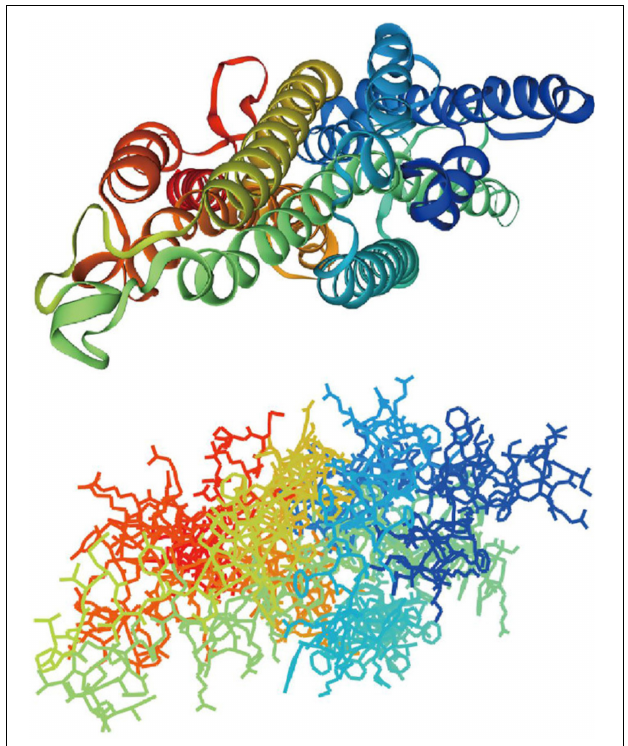
FIGURE 3 | Predicted structure of Lepidopteran SPRs BmOR3 and Orcos through SwissModel. In total, 7 transmembrane helixes were colored rainbow in the form of silk ribbon (Cartoon) and